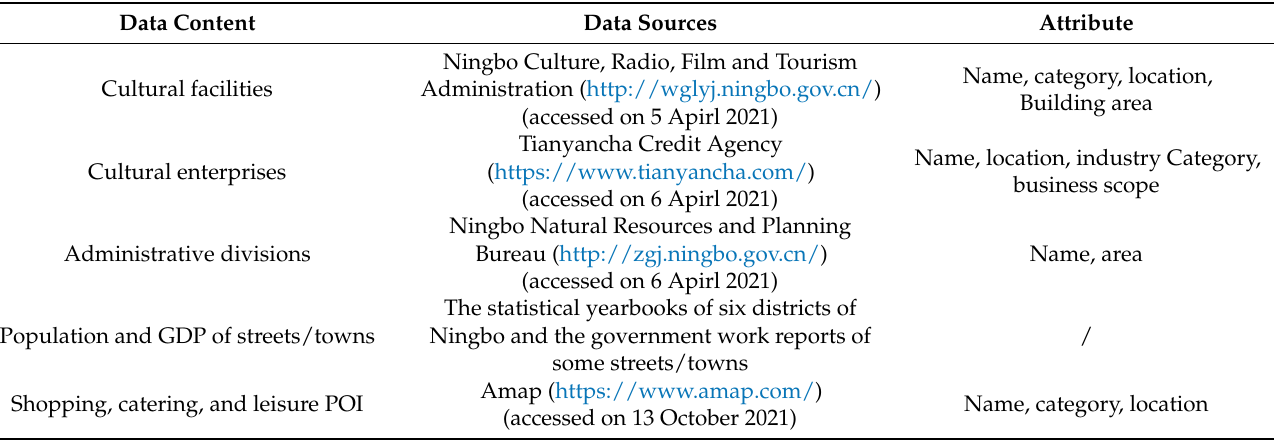
Table 3. Sources of research data.